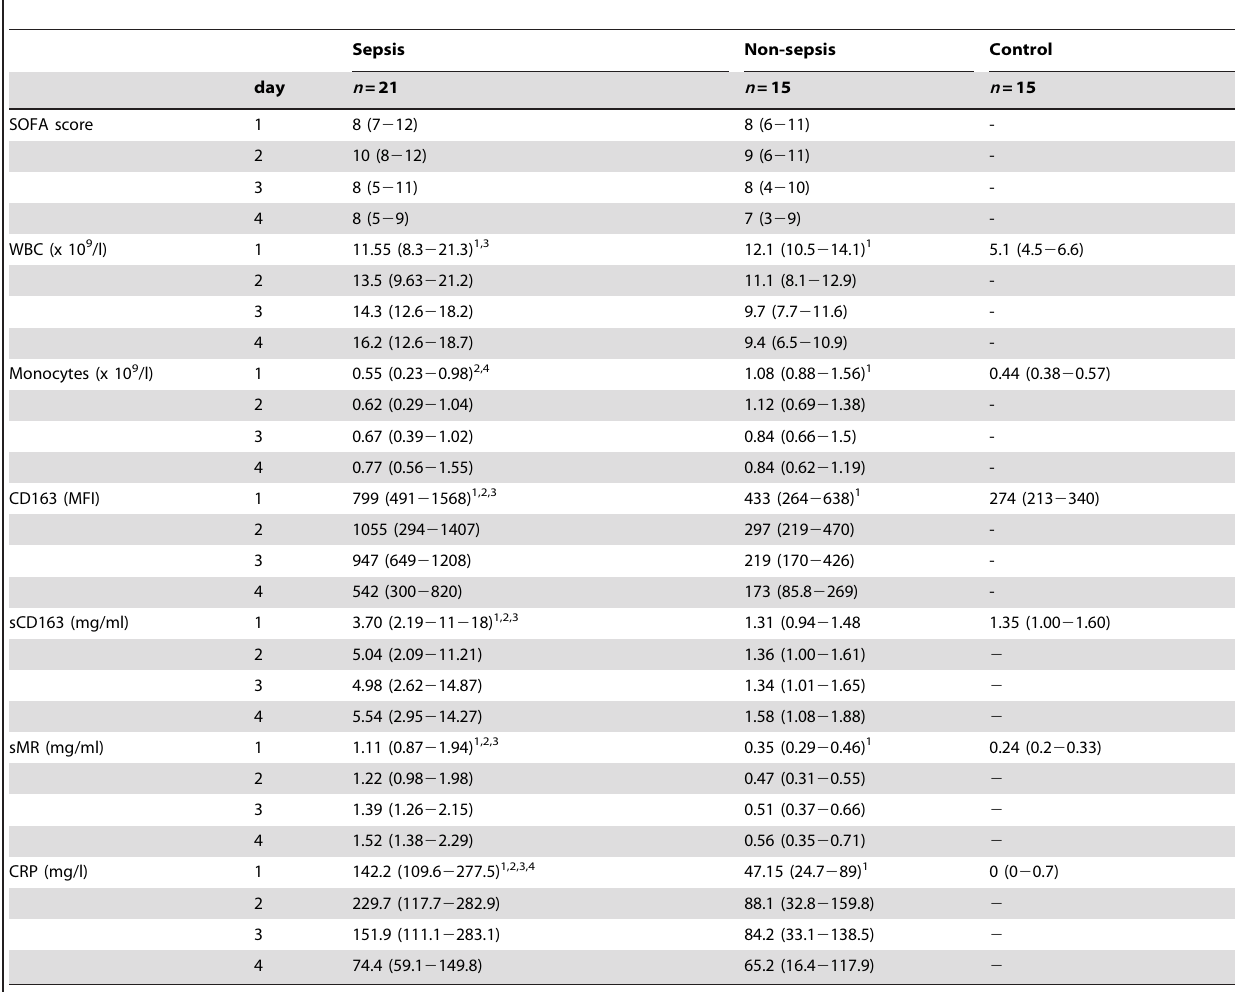
Table 2. SOFA score and biochemical variables during the study period.